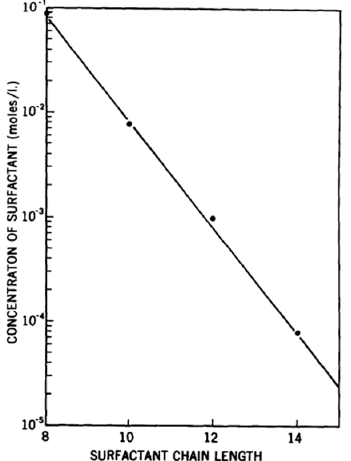
Figure 9. Concentration of SDS surfactant needed to maintain a precipitated complex versus surfactant chain length. Reprinted with permission from Goddard, E.D.; Hannan, R.B. Polymer/Surfactant Interactions. J. Am. Oil Chem. Soc . 1977 , 54 , 561–566. Copyright 1977, John Wiley and Sons [117].